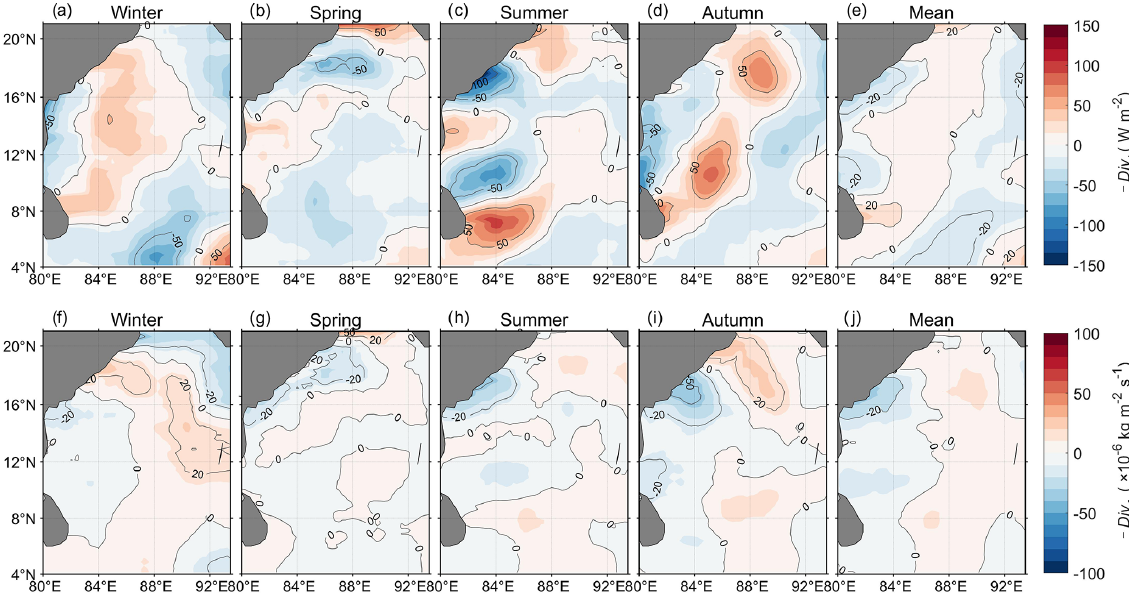
Figure 11. Divergence of the heat transport ( − Div h , a–e ) and freshwater transport ( − Div fw , f–j ) caused by eddies in different seasons in the Bay of Bengal. Positive values represent oceanic heat/freshwater gains from eddies; negative values represent oceanic heat/freshwater losses by